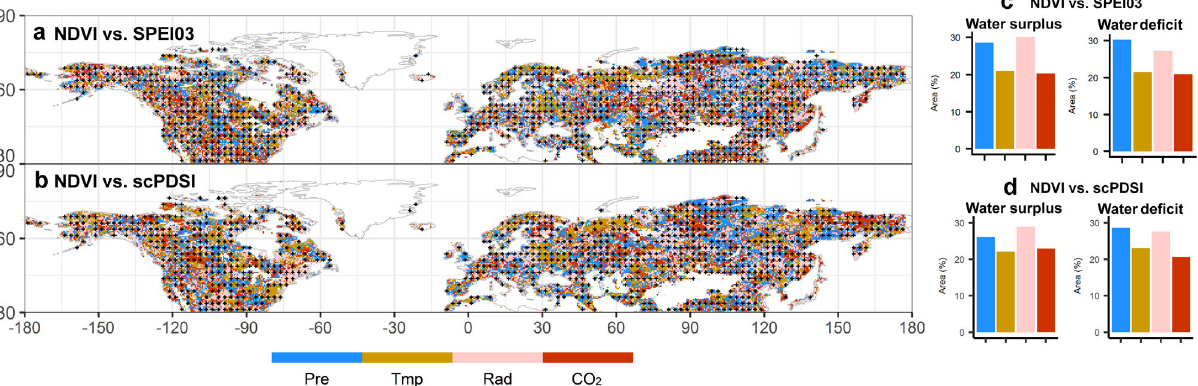
Fig. 4 Attribution of meteorological factors and atmospheric CO 2 to the correlations between normalized difference vegetation index (NDVI) anomaly and water availability indices over the last three decades. a , b are the spatial distributions of the dominant factor in fl uencing R NDVI-SPEI03 and R NDVI-scPDSI , respectively. The dots show the regions that R NDVI-SPEI03 or R NDVI-scPDSI variations are signi fi cantly explained by precipitation, radiation, temperature, and atmospheric CO 2 . c , d The percentage areas where the water de fi cit and water surplus responses can be explained by one of the four dominant factors (i.e., precipitation, temperature, radiation, and CO 2 ). Pre: precipitation, Rad: radiation, Tmp: temperature, CO 2 : atmospheric CO 2